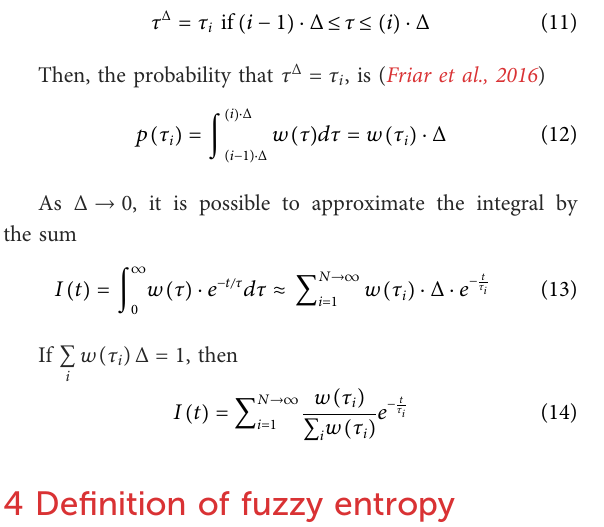
FIGURE 1 Quantization of the continuous variable τ